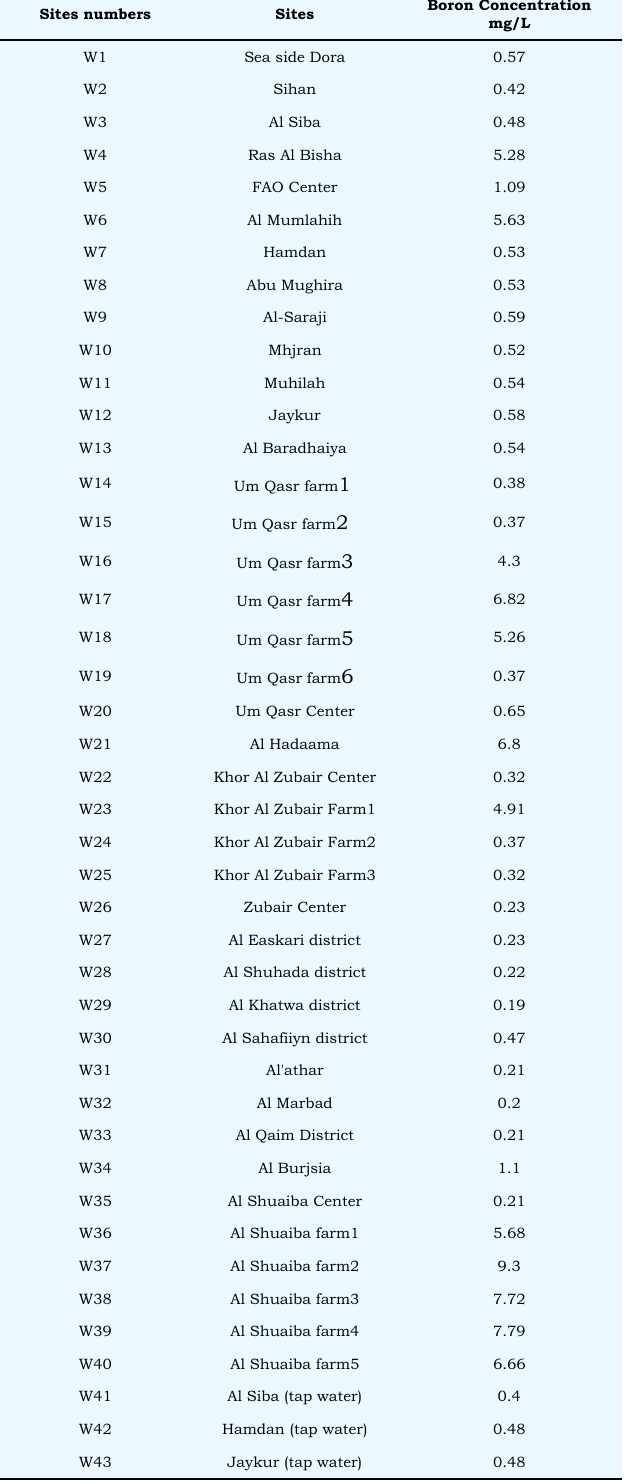
Table 1 ICP-OES analysis of boron water samples in southern Basrah Governorate